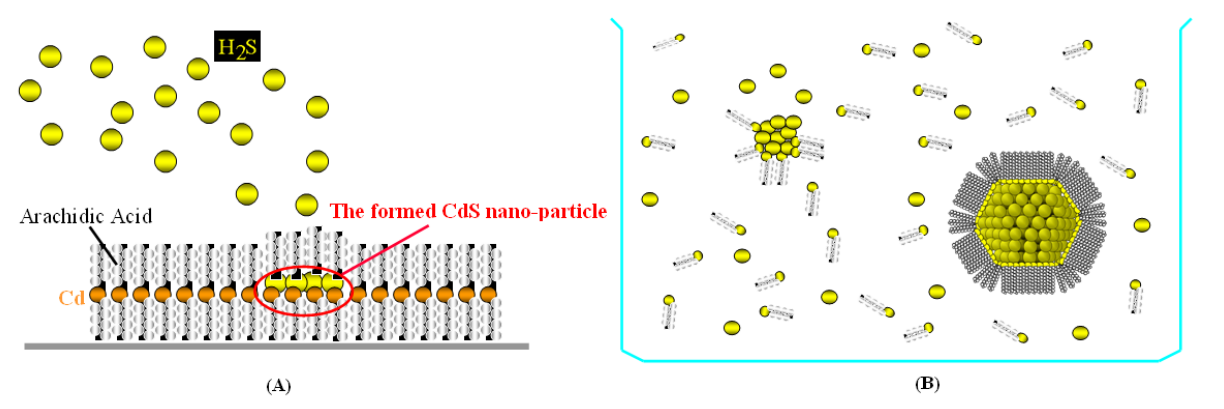
S) in creating 2 4